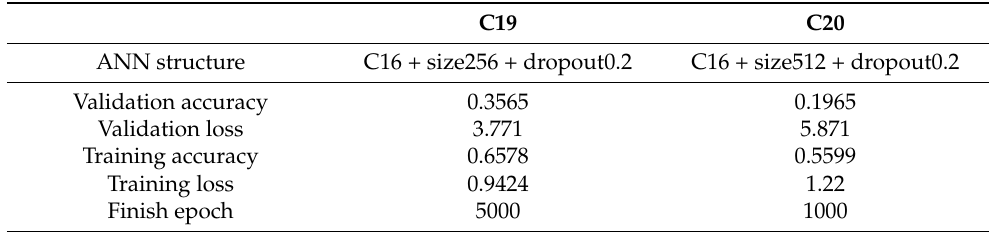
Table 8. Extra dense layer results.